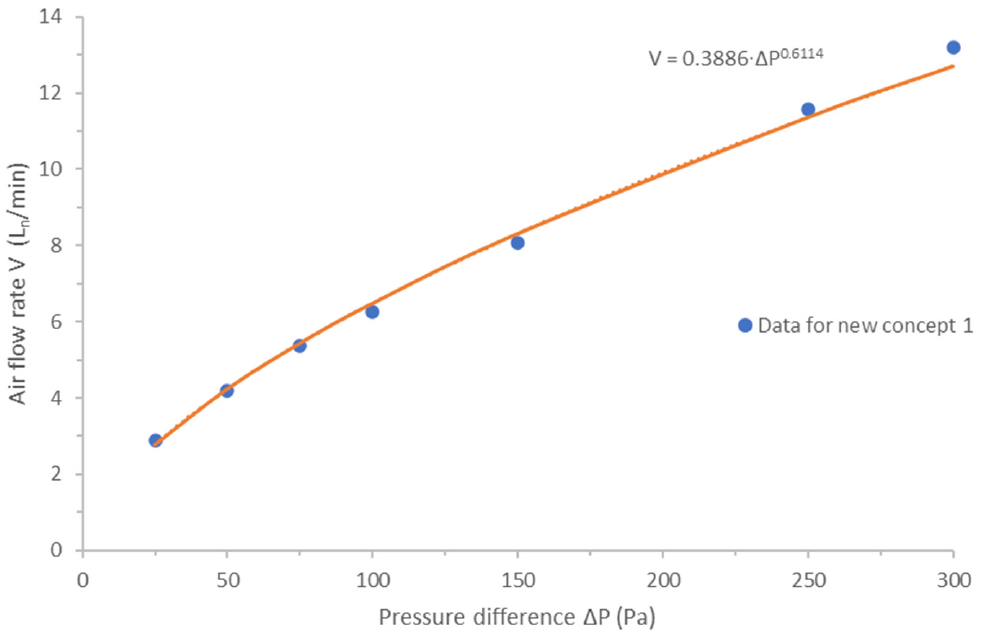
Figure 6. Example of flow rate equation, Equation (1), established through fitting of data.